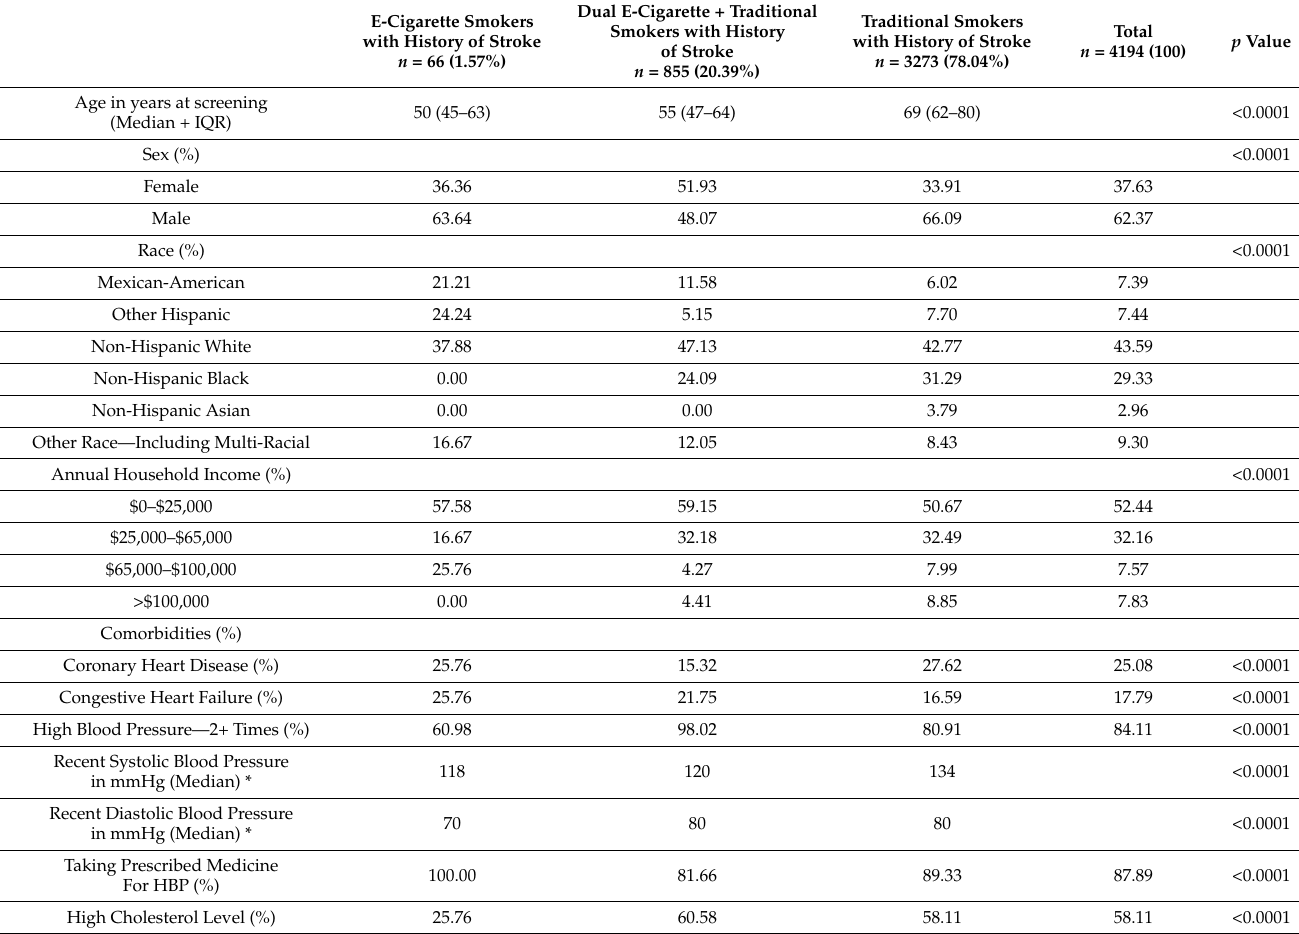
Table 2. Socio-demographics characteristics of various smoking habits among respondents with history of stroke ( n =